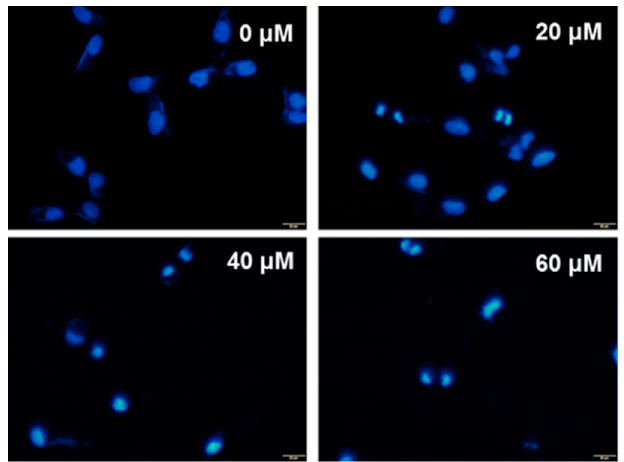
Figure 4. DAPI staining showing the effect of UA on chromatin condensation in SK-Hep-1 cells after treatment with 0, 20, 40, and 60 μ M UA for 24 h. Images were obtained with an Olympus IX81 microscope.